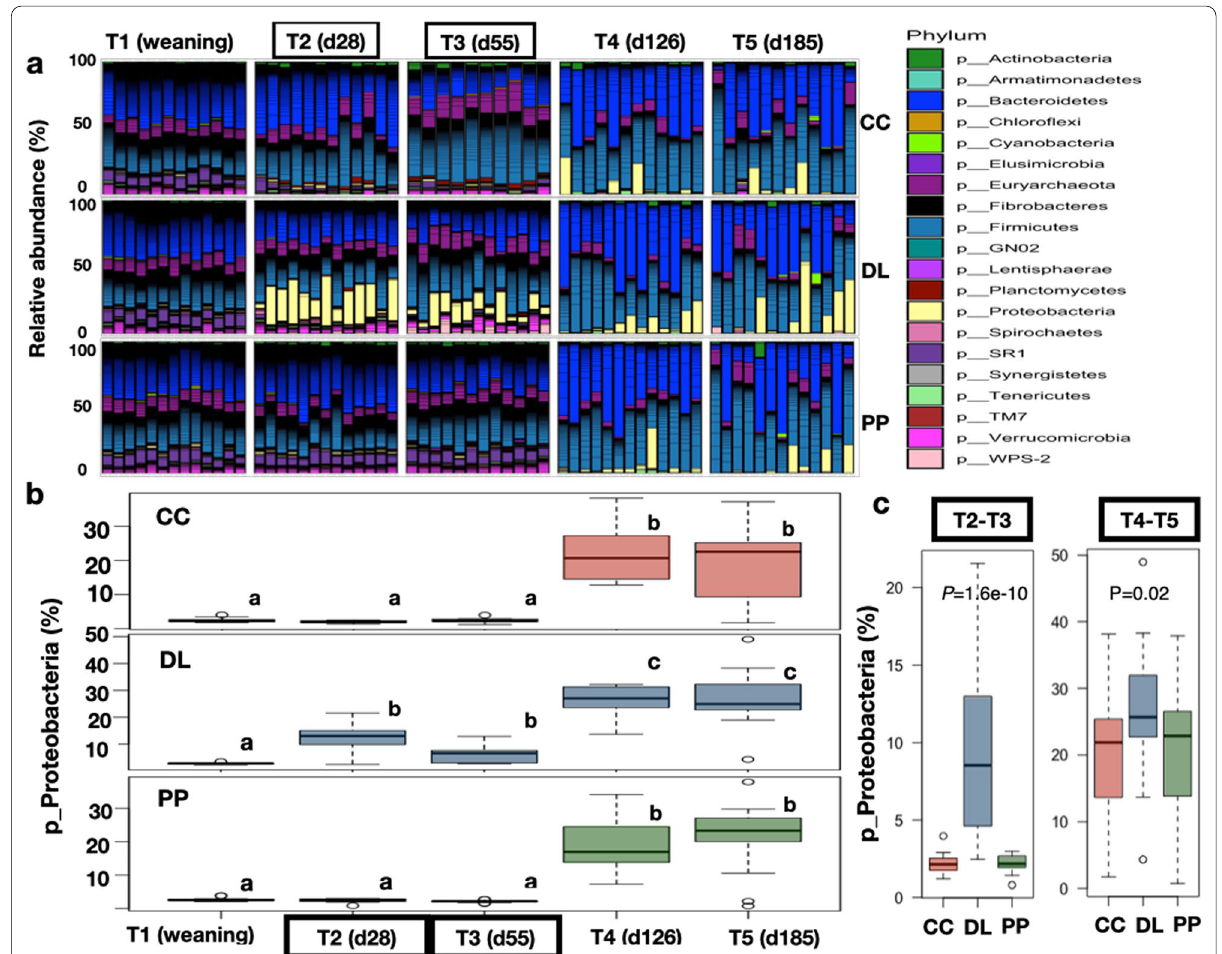
Fig. 2 Taxonomic composition at phylum level in the rumen microbiome of calves at weaning (T1), backgrounding (T2–T3), and finishing (T4– T5). a Barplot showing the relative abundance of phyla at weaning, backgrounding and finishing. b Boxplots showing relative abundances of Proteobacteria in calves within every BKG system, from weaning to finishing. c Boxplots showing relative abundances of Proteobacteria in calves within specific time points, BKG:T2–T3 and finishing: T4–T5. Dry lot (DL); cover crop (CC) and perennial pasture